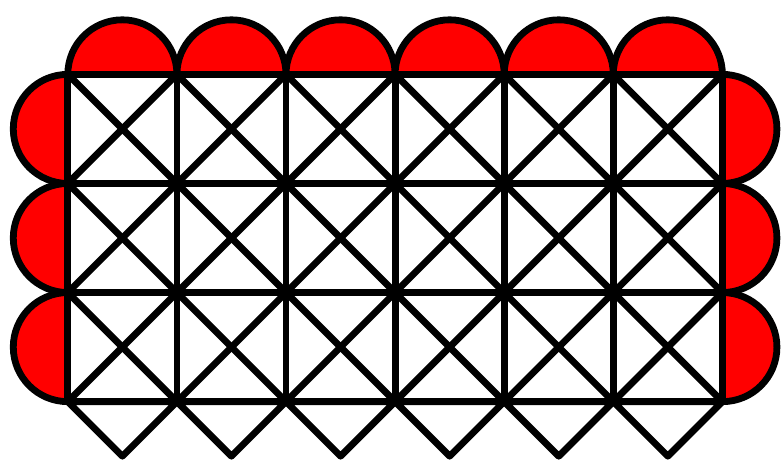
Figure 4. Ising proram construction for the case n = 6, k = 3.